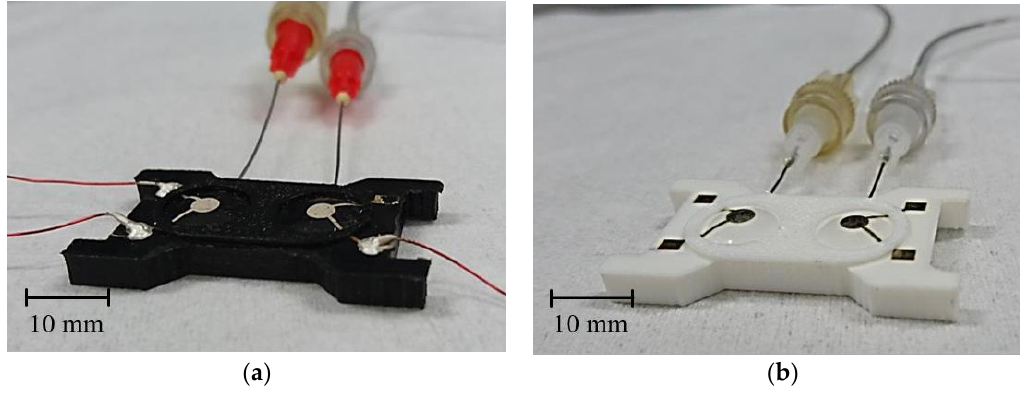
Figure 3. Electrode module with ( a ) screen-printed electrodes and black filament; and ( b ) with inkjet-printed electrodes and white filament.